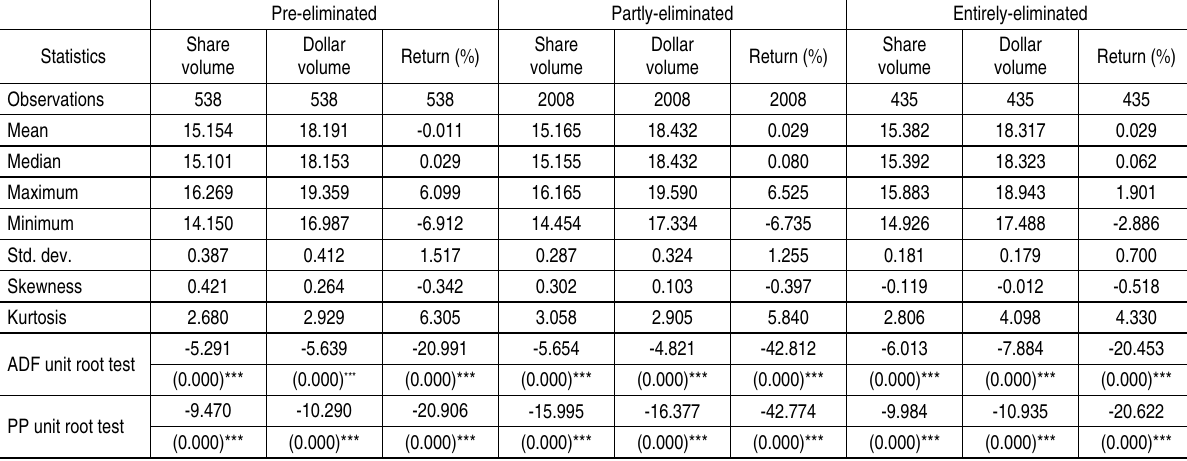
Table 2. Descriptive statistics for the share volume, dollar volume, and returns series of the equity index TAIEX: three